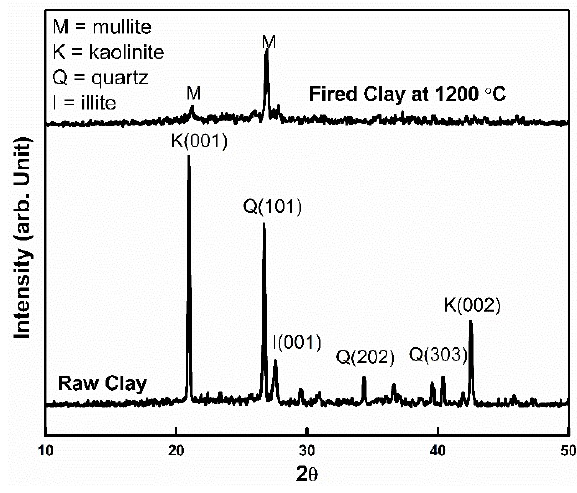
Figure 2. XRD patterns of ( a ) raw clay and ( b ) fired clay at 1200 °C.